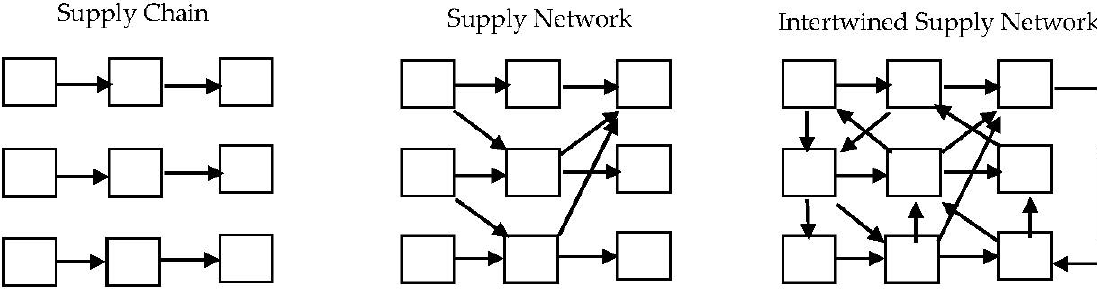
Figure 1 . Linear supply chains, supply networks and intertwined supply networks [25]. Figure 1. Linear supply chains, supply networks and intertwined supply networks